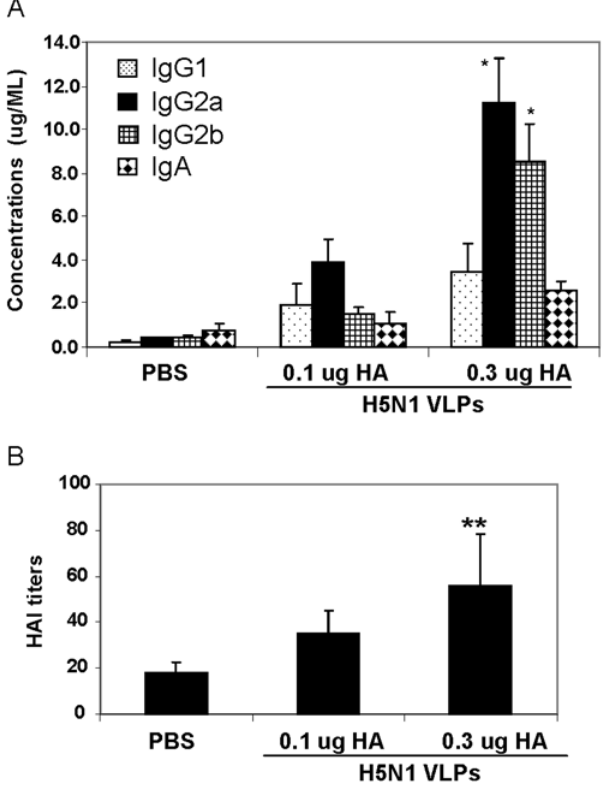
Figure 3. Isotypes of antibody responses induced by H5N1 VLP immunization. Serum samples collected at week 28 post immuniza- tion were used to determine levels of isotype antibodies specific to influenza H5N1 virus (A, n=6) and hemagglutination inhibition titers (B, n=5). Error bars are shown to indicate standard deviation. * (A) Indicates statistically significant differences between 0.1 m g HA and 0.3 m g HA groups (p , 0.02). ** (B) statistical significance between 0.3 m g HA and PBS mock groups (p , 0.02).